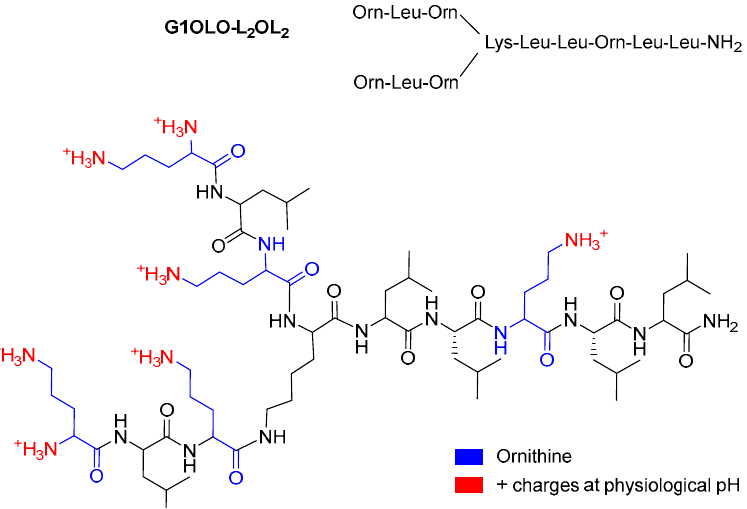
Figure 1. Chemical structure of the G1OLO-L 2 OL 2 peptide.